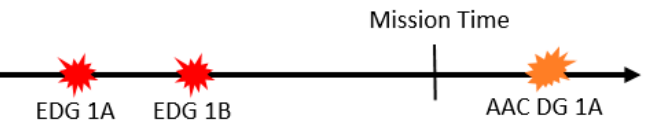
Figure 10. Cutsets can depend on the time of a component’s failure based on the mission time.